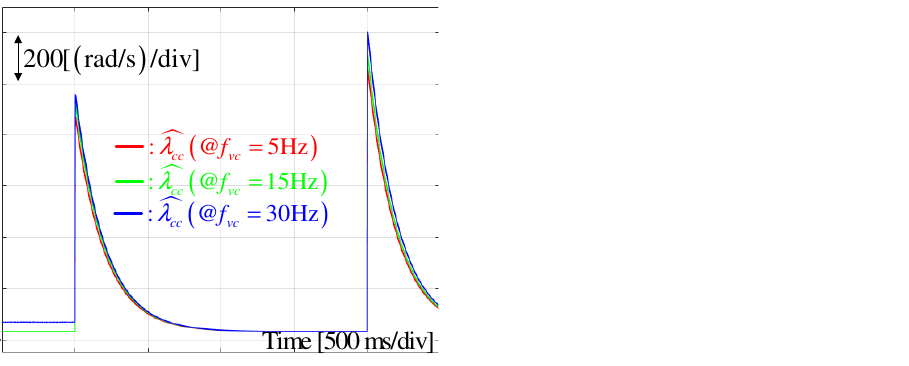
Figure 12. Auto-tuner responses at f vc = 5, 15, and 30 Hz, and pulse reference tracking mode of R L = 20 Ω .